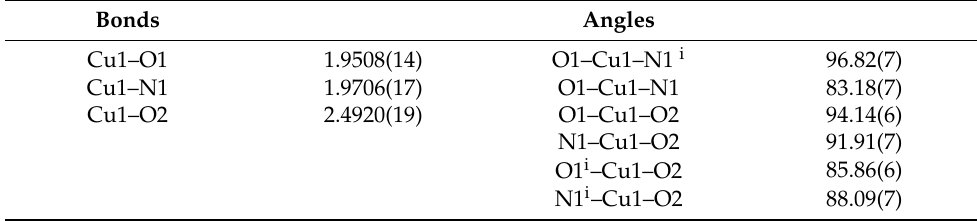
Figure 4. Molecular structure of 5 . Displacement ellipsoids are drawn at the 50% probability level. Only one position of carbon atoms of DMF is shown because of clarity. Symmetry code: i = − x + 1, − y + 1, − z . Table 2. Selected bond lengths [Å] and angles [°] for 5 .